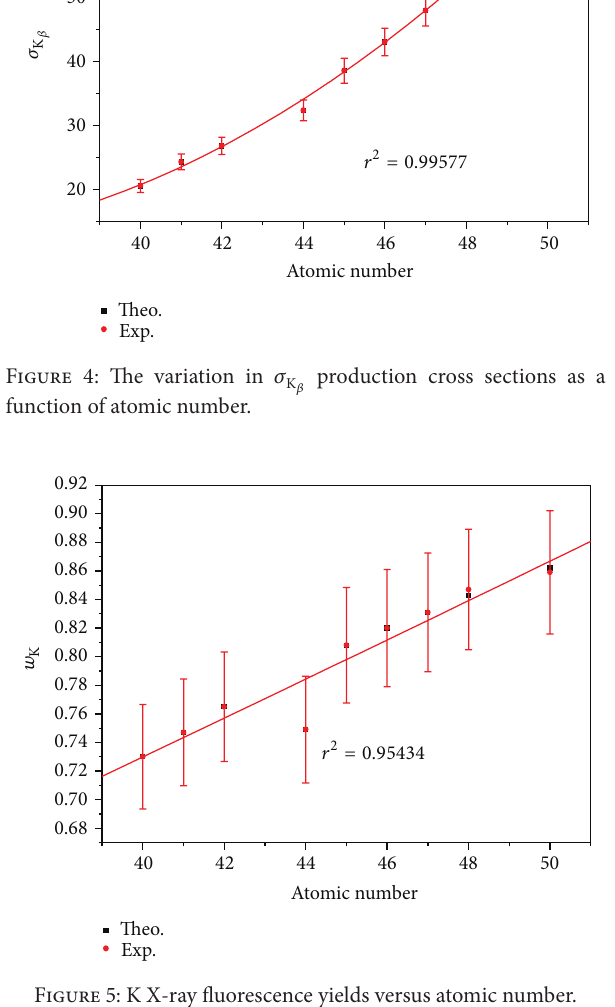
Figure 5: K X-ray fluorescence yields versus atomic